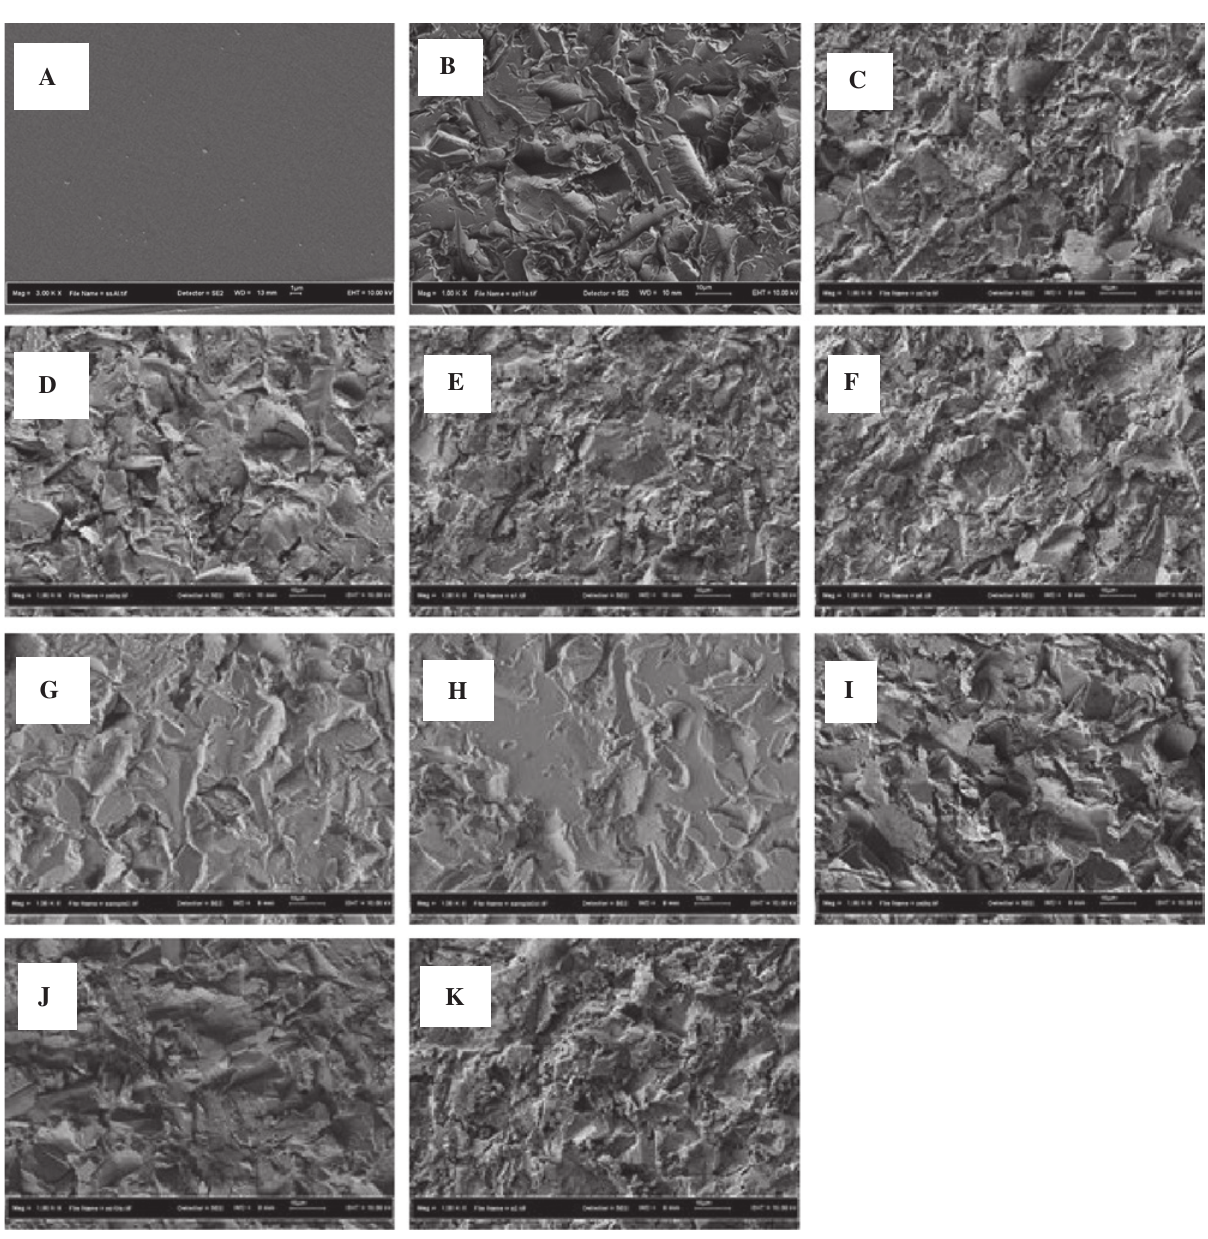
Figure 5 FE-SEM images of polished (A), sandblasted (B), SLA for 10 s at 25 ° C (C), SLA for 20 s at 25 ° C (D), SLA for 30 s at 25 ° C (E), SLA for 10 s at 45 ° C (F), SLA for 20 s at 45 ° C (G), SLA for 30 s at 45 ° C (H), SLA for 10 s at 60 ° C (I), SLA for 20 s at 60 ° C (J), and SLA for 30 s at 60 ° C